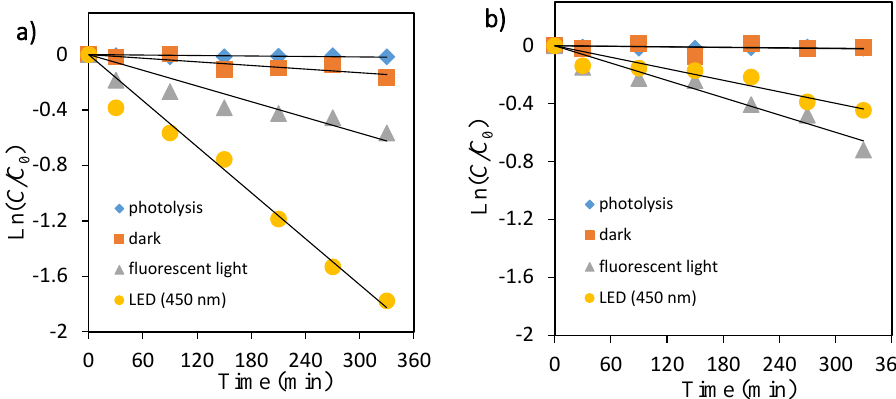
Figure 5. Kinetic plot of Ln( C/C 0 ) versus irradiation time for the photocatalytic degradation of orange II. ( a ) TiO 2 , ( b ) ZnO.